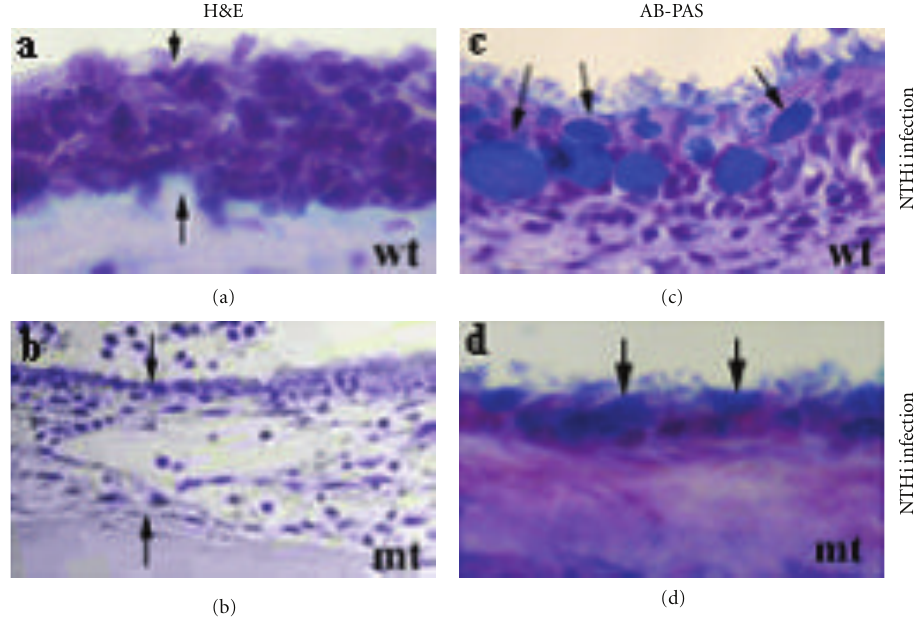
Figure 7: The middle ear mucosa in the wildtype (wt) mice responds to the challenge of nontypable H. influenzae (NTHi) and increases its mucous cell number (c). The middle ear mucosa in the interleukin 10 (IL-10) knockout mutant (mt) mice exhibits fewer mucous cells in response to NTHi infection (d). Arrows pointing to mucous